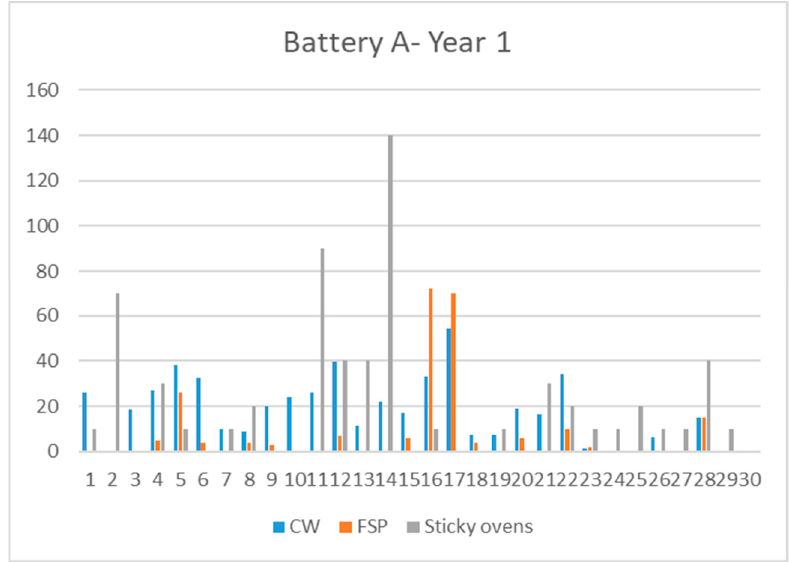
Figure 12. Sticky ovens and refractory repairs battery A, year 1.